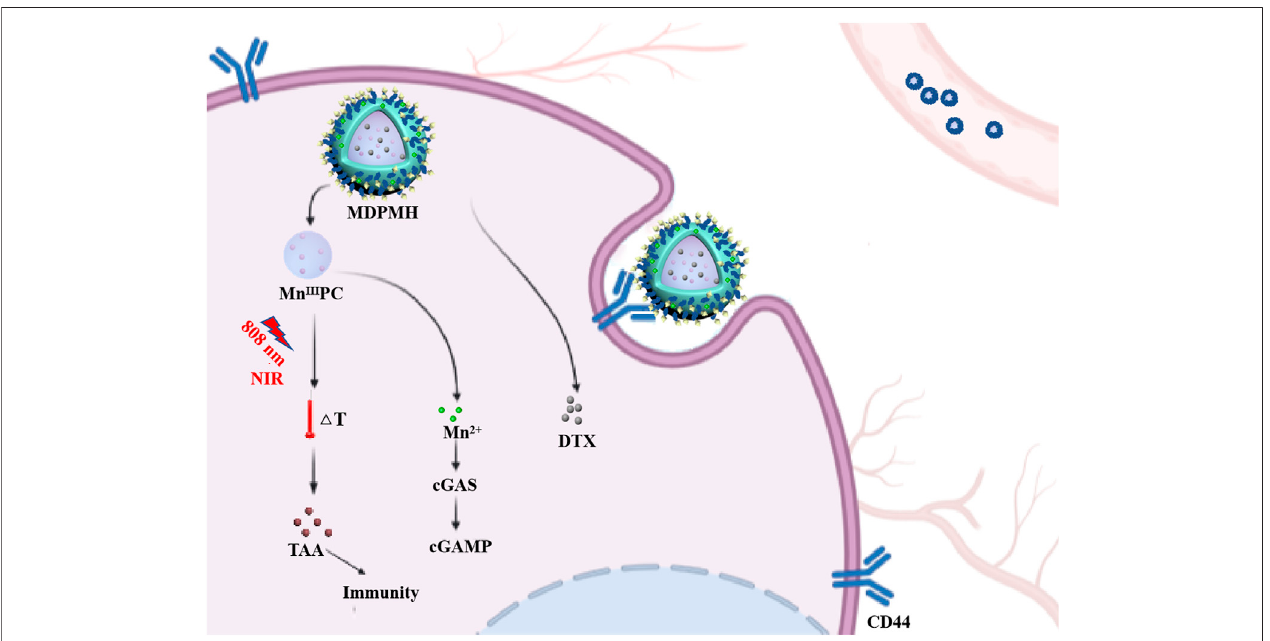
FIGURE 1 | Schematic illustration of combinational therapy of PTT, chemotherapy, and immunotherapy (MDPMH) via a combined all-in-one and all-in-control strategy.